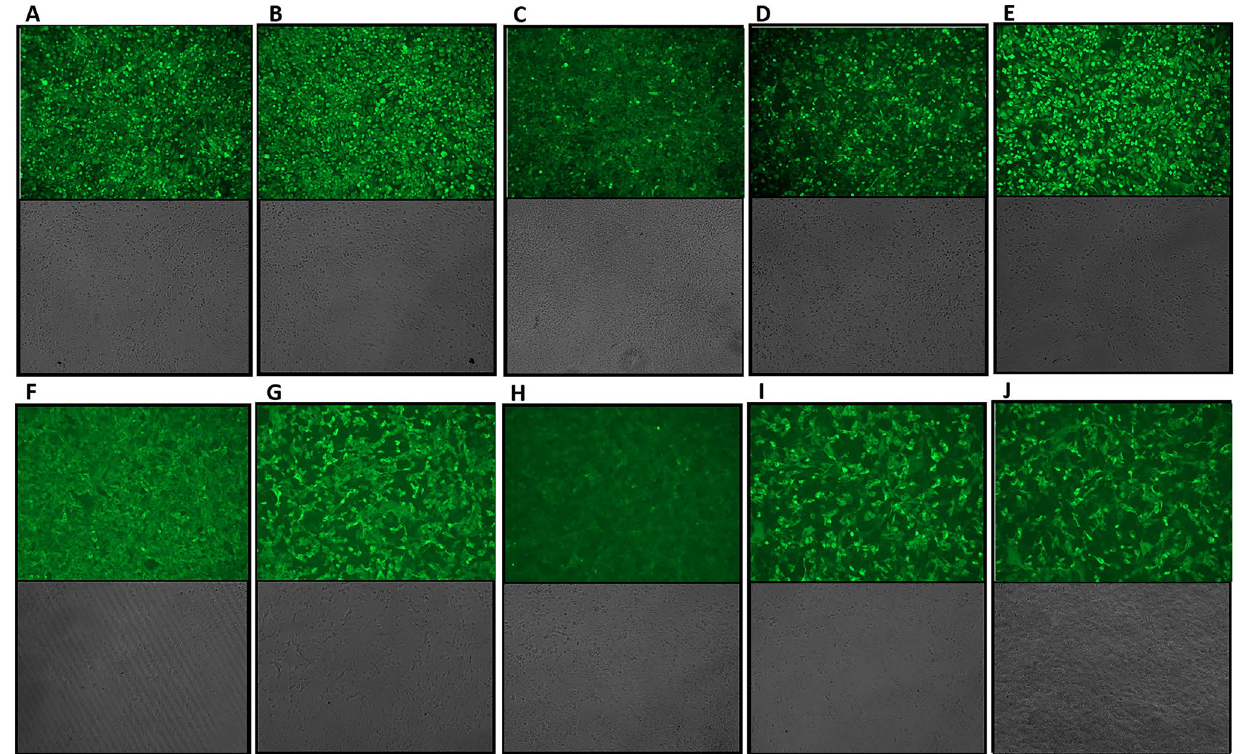
Figure 4. Detection of p30 protein expression by immunofluorescence assay. Monolayers of DF-1 and Vero cells were infected with each MVA-p30 virus at an MOI of 1, and processed 24 h after infection. All images were acquired using a 10X objective and a green filter set at 70% intensity. Row A to E corresponds to DF-1 cells, and row F to J to Vero cells. Each column corresponds to: ( A , F ) MVA-PrMVA-13.5L-p30, ( B , G ) MVA-pHyb-p30,